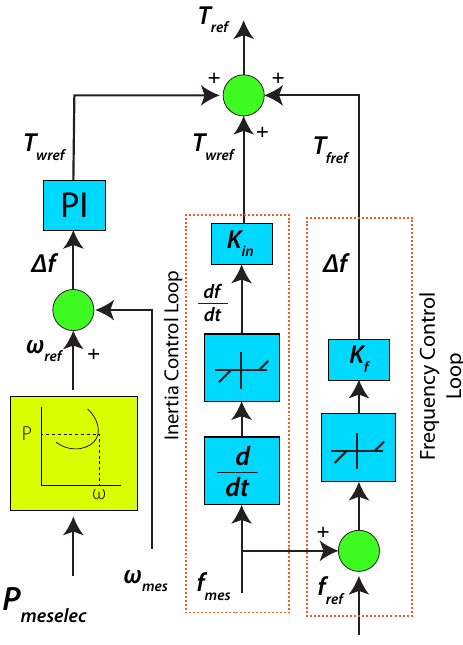
Figure 10. Two-loop inertia